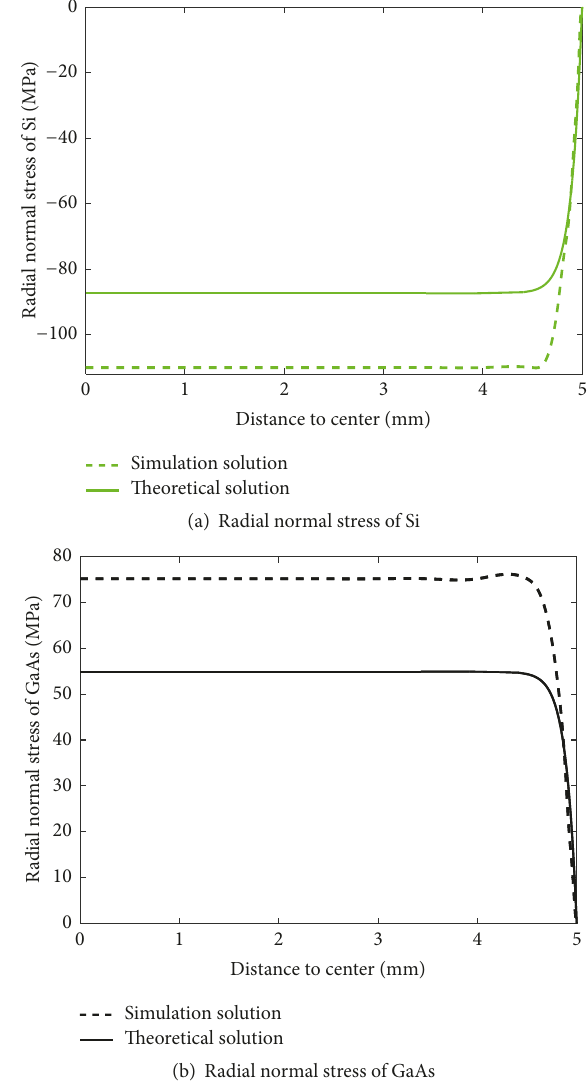
(b) Radial normal stress of GaAs Figure 6: Theoretical solution and simulation solution distributions of the radial normal